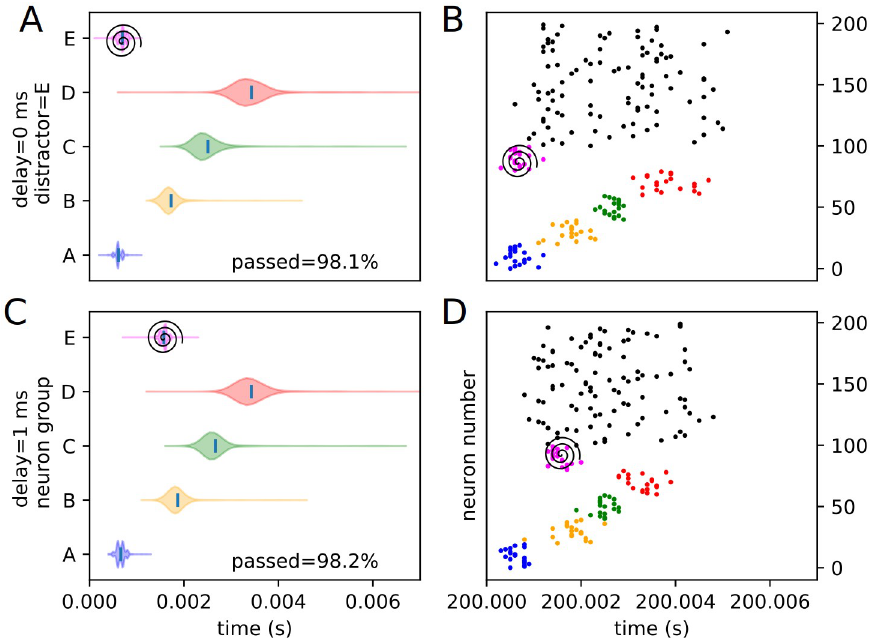
Fig 16. Experimental peak densities for early distractors at position E. Violin plots (densities estimated with a 50 point Gaussian kernel) of the peak times for the first two temporal variants of distraction at position E, with listed percentages of trials passing veto. A raster plot of an example distracted recall is also included. The spiral indicates the location of the distractor. (A) Violin plot for distractor E with 0 ms delay. (B) Example replay for distractor E with 0 ms delay. (C) Violin plot for distractor E with 1 ms delay. (D) Example replay for distractor E with 1 ms delay.